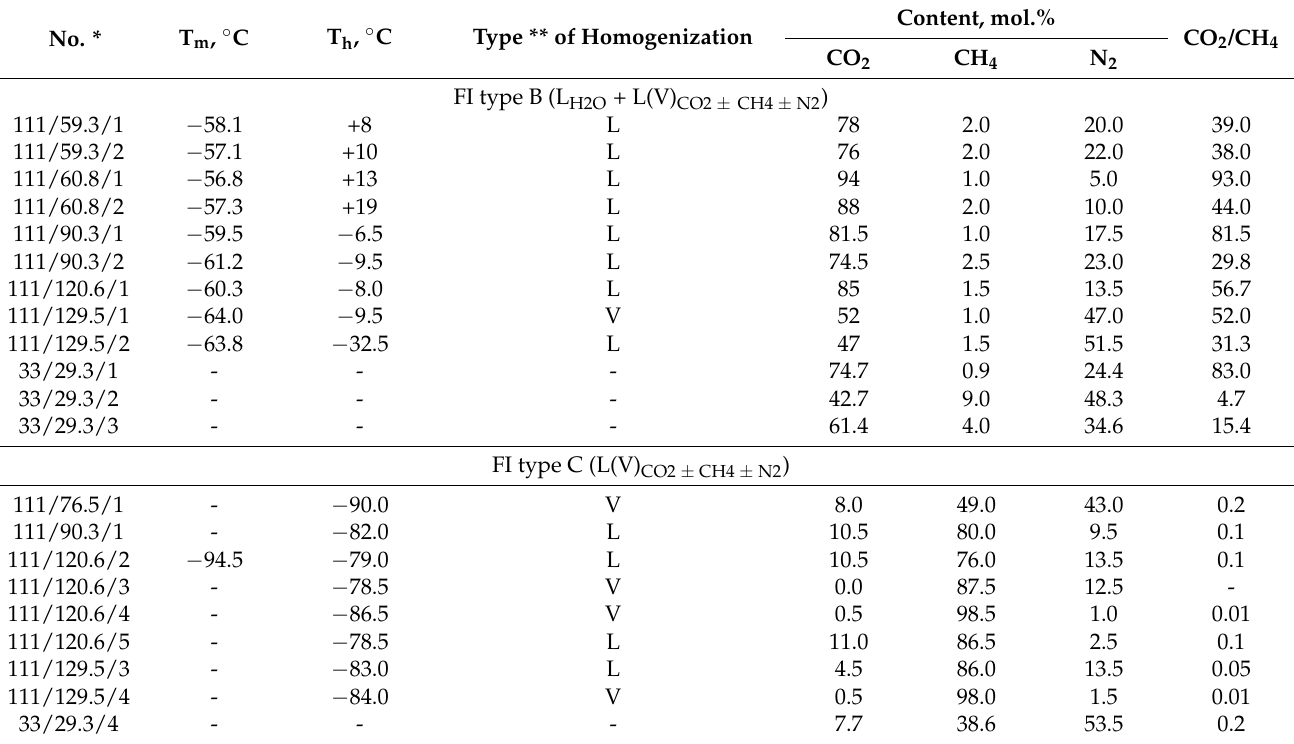
Table 2. Microthermometric characteristics and composition of the gas phase of individual fluid inclusions in quartz of the Blagodatnoye gold deposit (according to Raman spectroscopy data).